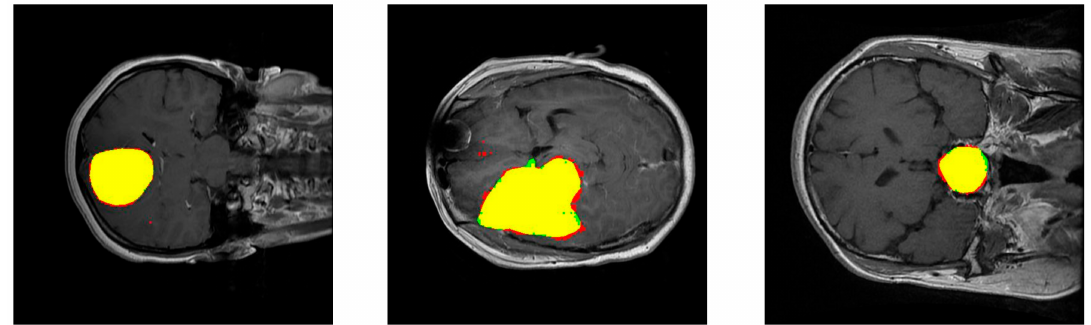
Figure 4. Examples of results of the proposed method for three slices corresponding to meningioma, glioma, and pituitary tumors, respectively. The images show the tumor segmentation: The region detected is shown in red while the ground truth region is shown in green. As a result, the intersection region is shown in